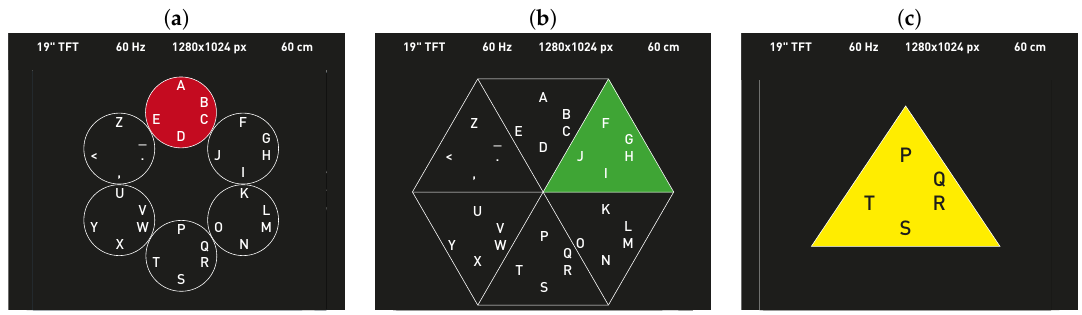
Figure 10. Three variations of the Hex-O-Spell with ERP for gaze-independent BCI studies. ( a ) Hex-O-Spell; ( b ) Cake Speller; ( c ) Center Speller. Figure modified from Treder et al., 2011